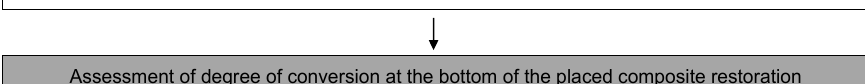
Figure 1. Experimental design and schedule.